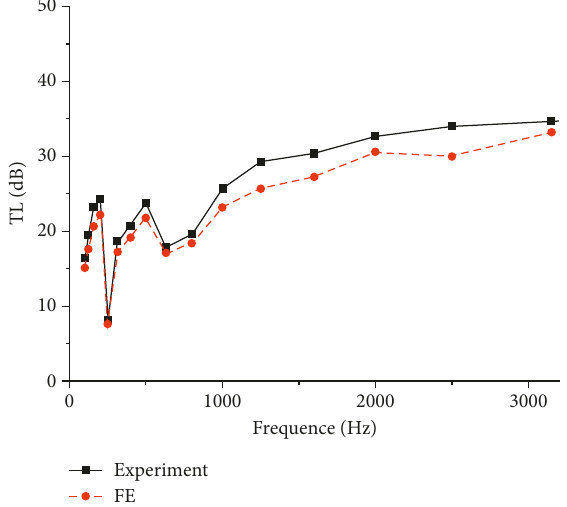
Figure 8: Comparison of sound insulation curves of SPS obtained through test and